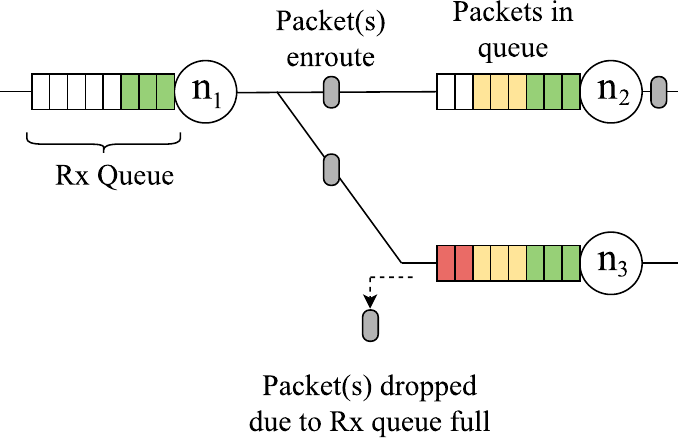
Figure 2. Packet loss/dropped due to full queue buffer.